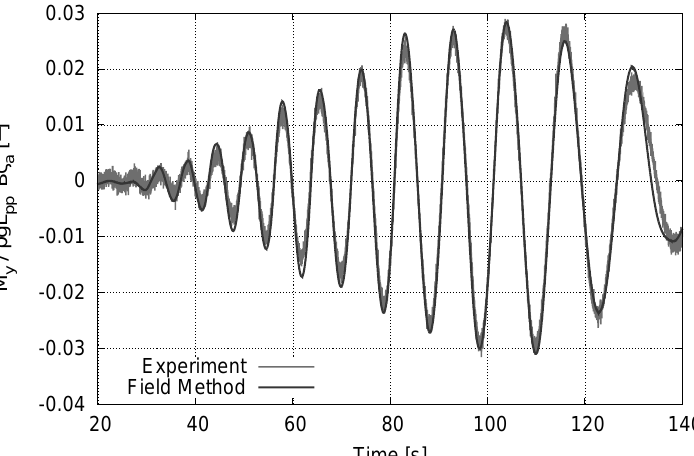
Figure 13. Chemical tanker: time histories of field method computed and measured (normalized) midship vertical bending moment M y . ρ is the water density, g the gravity constant, B the ship’s breadth, L pp the ship length and ζ a the free surface elevation.